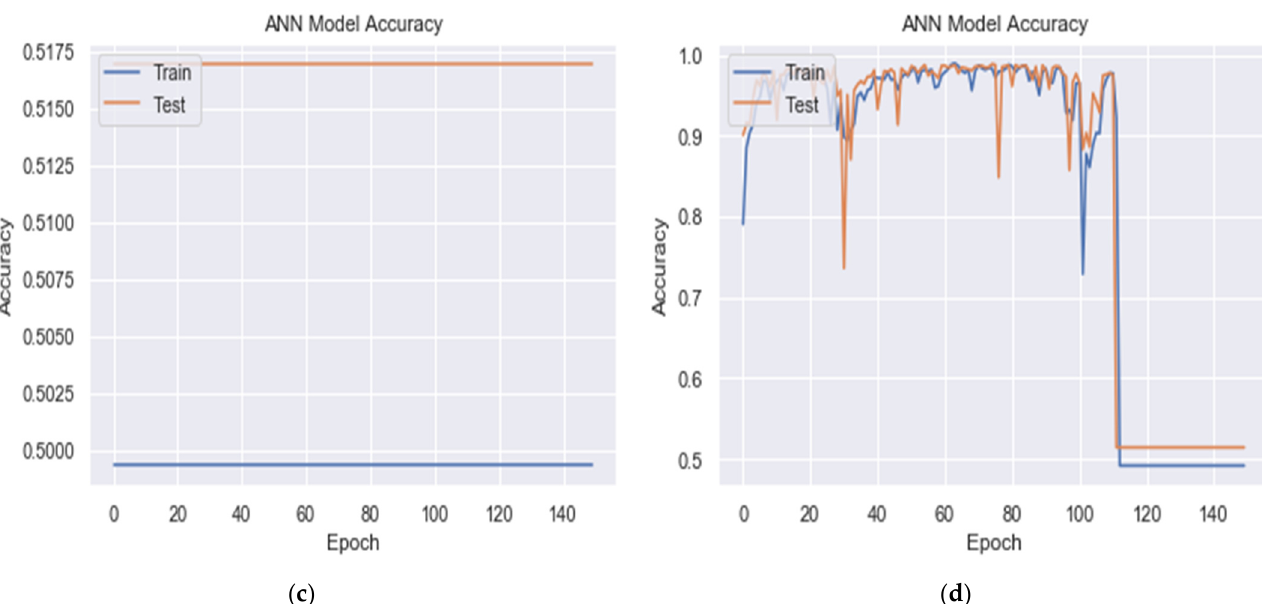
Figure 5. Training and validation accuracy for DDoS detection of the BDLSTM-autoencoder model using different activation functions at output layer ( a ) sigmoid, ( b ) RelU, ( c ) SoftMax, and ( d ) tanh for 80-10-10 splitting. Table 6. Results of tests using the UNSW2018 dataset for three models.